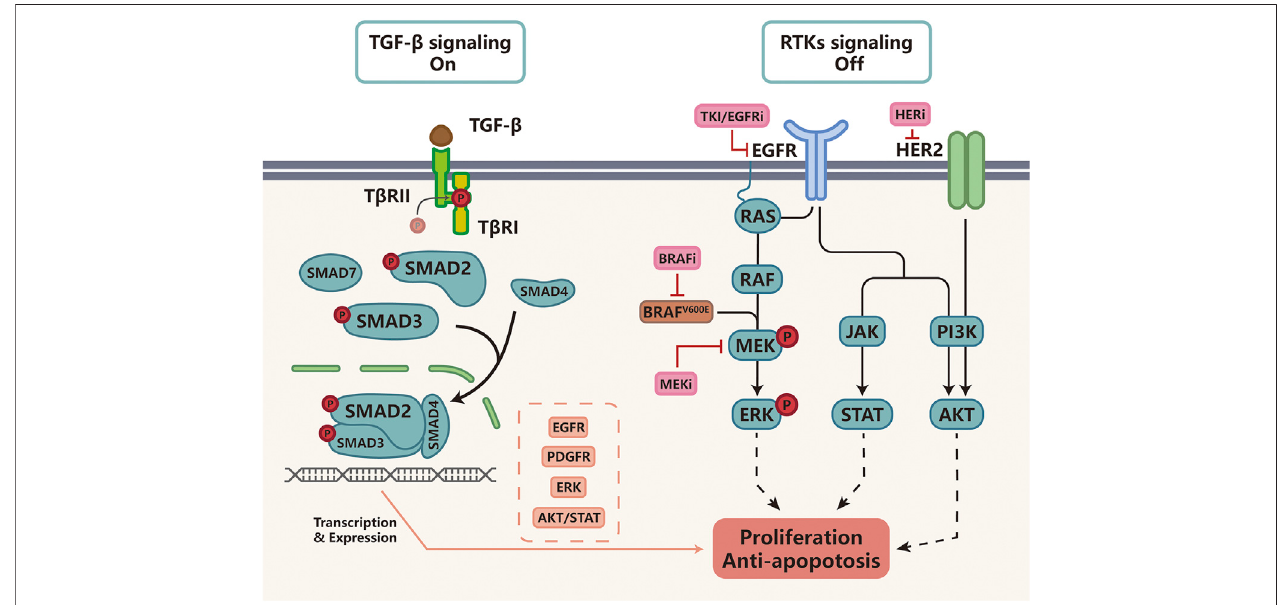
FIGURE 2 | TGF- β signaling and resistance to targeted therapy Cancers with activating BRAF-mutations or EGFR-mutations as well as HER2-positive cancer are often treated with small molecular inhibitors against these molecular targets. For example, BRAF V600E is often targeted by BRAFi such as vemurafenib, MEK by MEKi suchastramelinib,andHER2bytrastuzumab,Uponkinaseinhibitortreatment,receptortyrosinekinase(RTK)signalingisturnedoff.IncellsthatactivateTGF- β -induced drug resistance, TGF- β signaling functions by increasing the expression of EGFR, PDGFR, ERK, AKT/STAT to activate alternative survival pathways and suppress apoptosis, protecting tumor cells from targeted